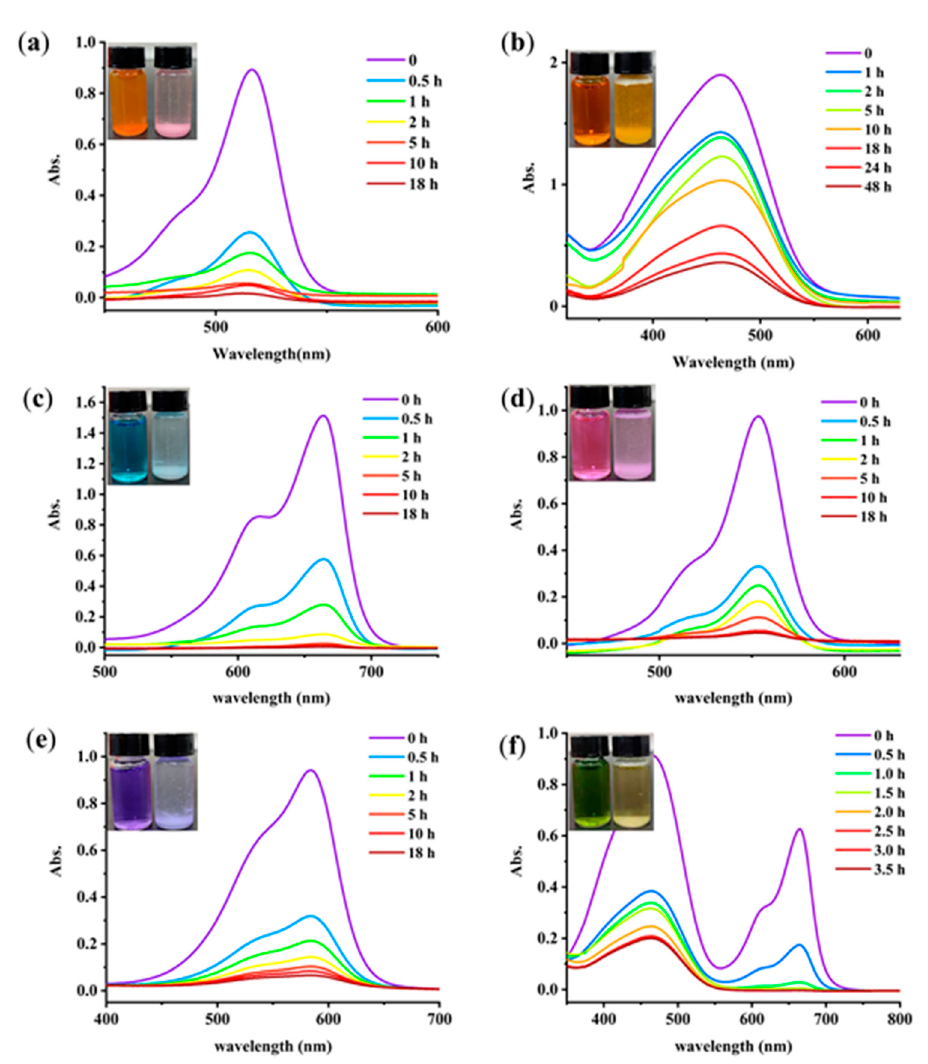
Figure 5. UV–vis spectra of the dye solutions suspended with the GA-O-09/Cu 2+ shrunken gel: ( a ) EY, ( b ) MO, ( c ) MB, ( d ) R6G, ( e ) MC and ( f ) a mixture of MO/MB for the indicated time, (inset) photos of the dye solutions before (left) and after (right) the removal by the GA-O-09/Cu 2+ shrunken gel.